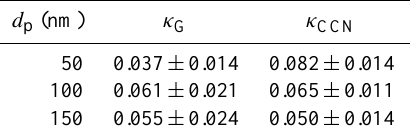
Table 5. Average hygroscopicity parameters ( κ) plus standard de- viations for freshly emitted wood burning particles. The values rep- resent averages over all nine biomass burning